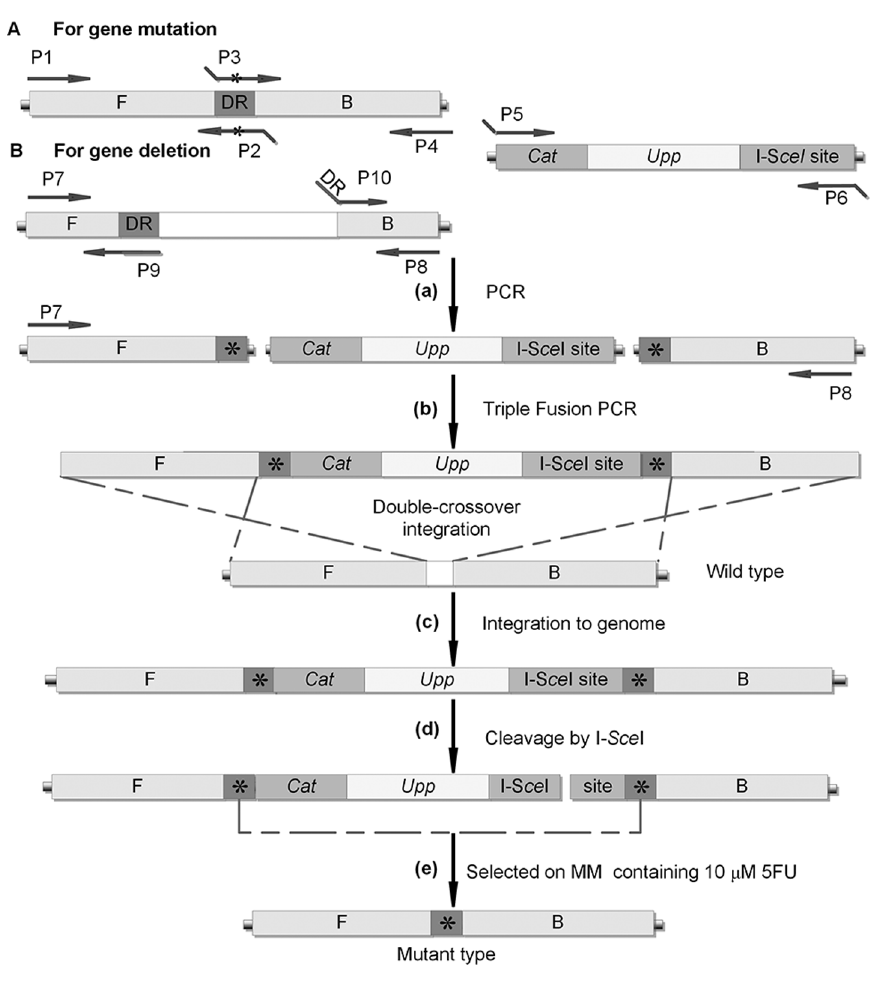
Figure 3. Scheme for mutation delivery procedure in B.subtilis . A. (a) For purpose of gene point-mutation, the upstream and downstream fragments carrying the mutation site (*) were amplified by PCR with primer pairs P1/P2 and P3/P4, and upp -cassette was amplified by PCR with primer pairs P5/P6, respectively. (b) A triple fusion PCR reaction joined them with the upp -cassette. (c) PCR-fused product was used directly to transform BUK, and integration of the upp -cassette by first double-crossover event yields 5FU S Cm R transformants. (d) The shuttle vector pEBS- cop 1 was transformed into the 5FU S Cm R strain to cleavage of the chromosome at the recognition site by I-S ce I under xylose induction. (e) The excision of upp -cassette through the single-crossover event between the 30 bp DR stimulated by DSB generated a 5FU R Cm S strain that carried only the desired mutation without any other modification in the chromosome. B. For gene deletion, the upstream and downstream fragments carrying the same DR sequence (*) were amplified by PCR with primer pairs P7/P9 and P10/P8. The remainder of the procedure was essentially the same as above described.